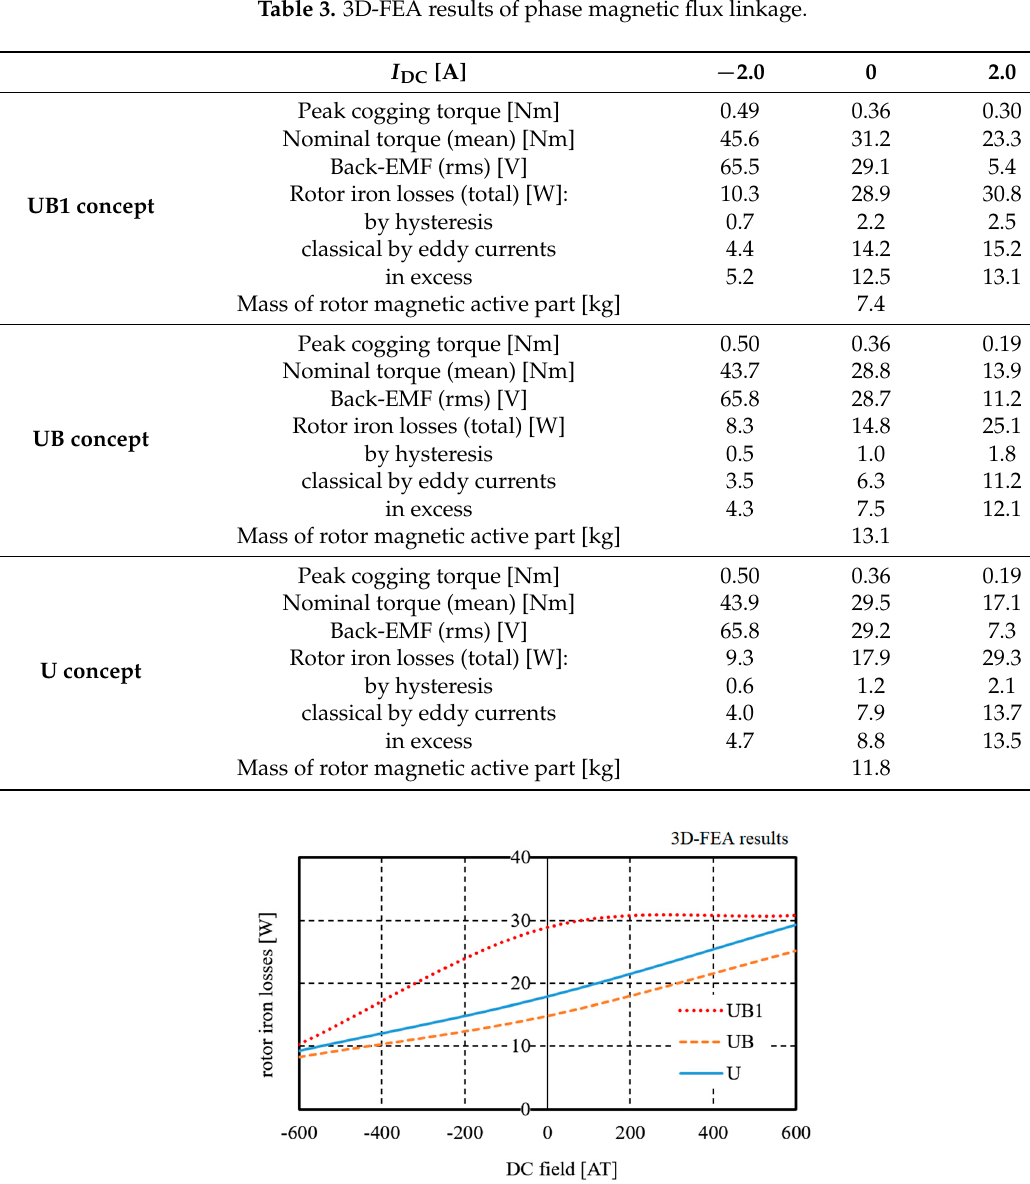
kg/m 3 Table 3. 3D-FEA results of phase magnetic flux linkage. I DC [A]